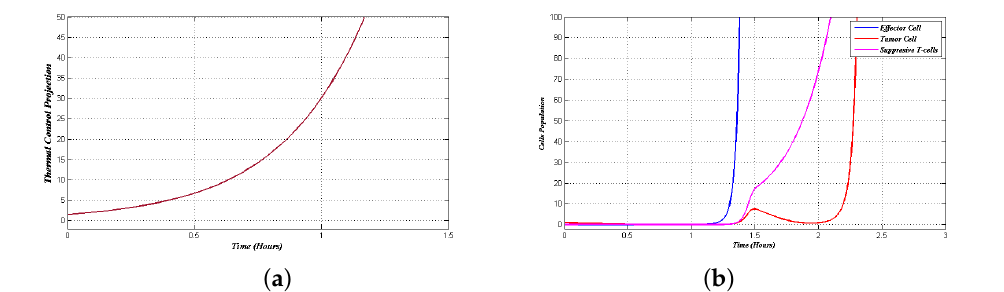
Figure 2. Numerical result for thermal optimal control when σ = ¯ H in System (1). ( a ) Thermal control projection ( b ) Cell